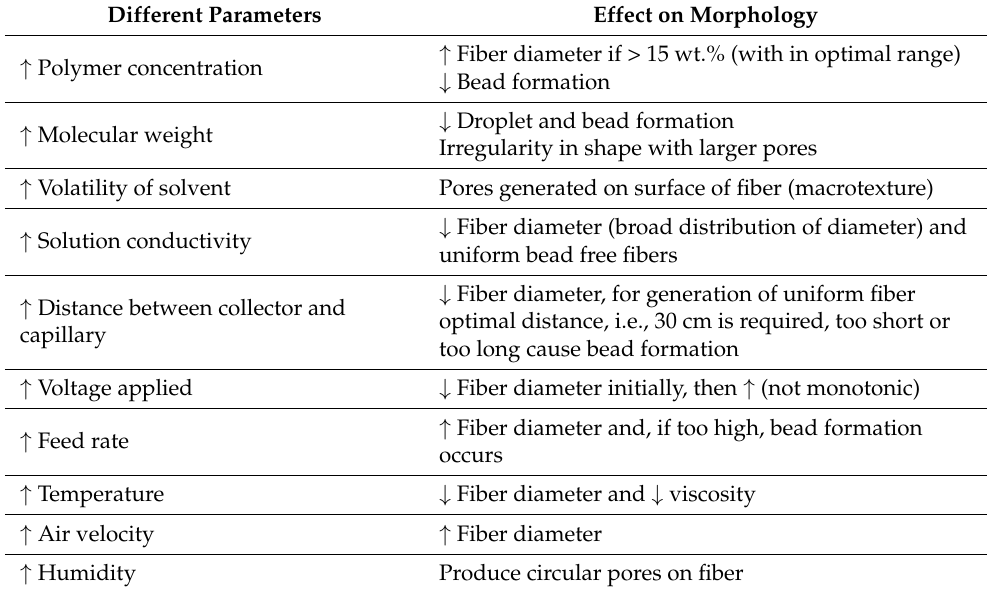
Table 4. Summary of parameters effecting morphology of electrospun